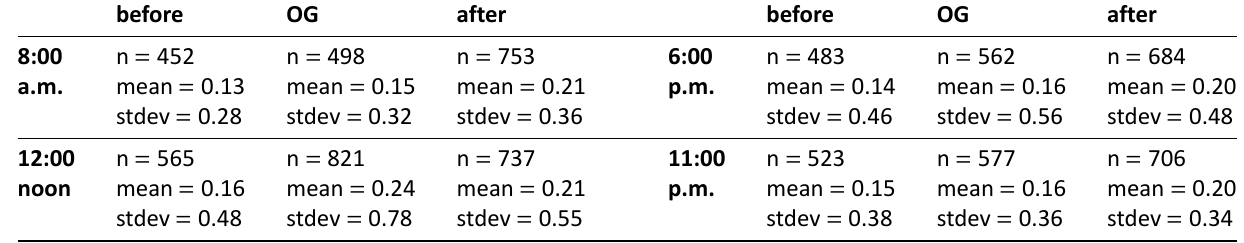
Table 4. Values for the hot spot analysis using KDE for visitors’ positive tweets for specific hours.